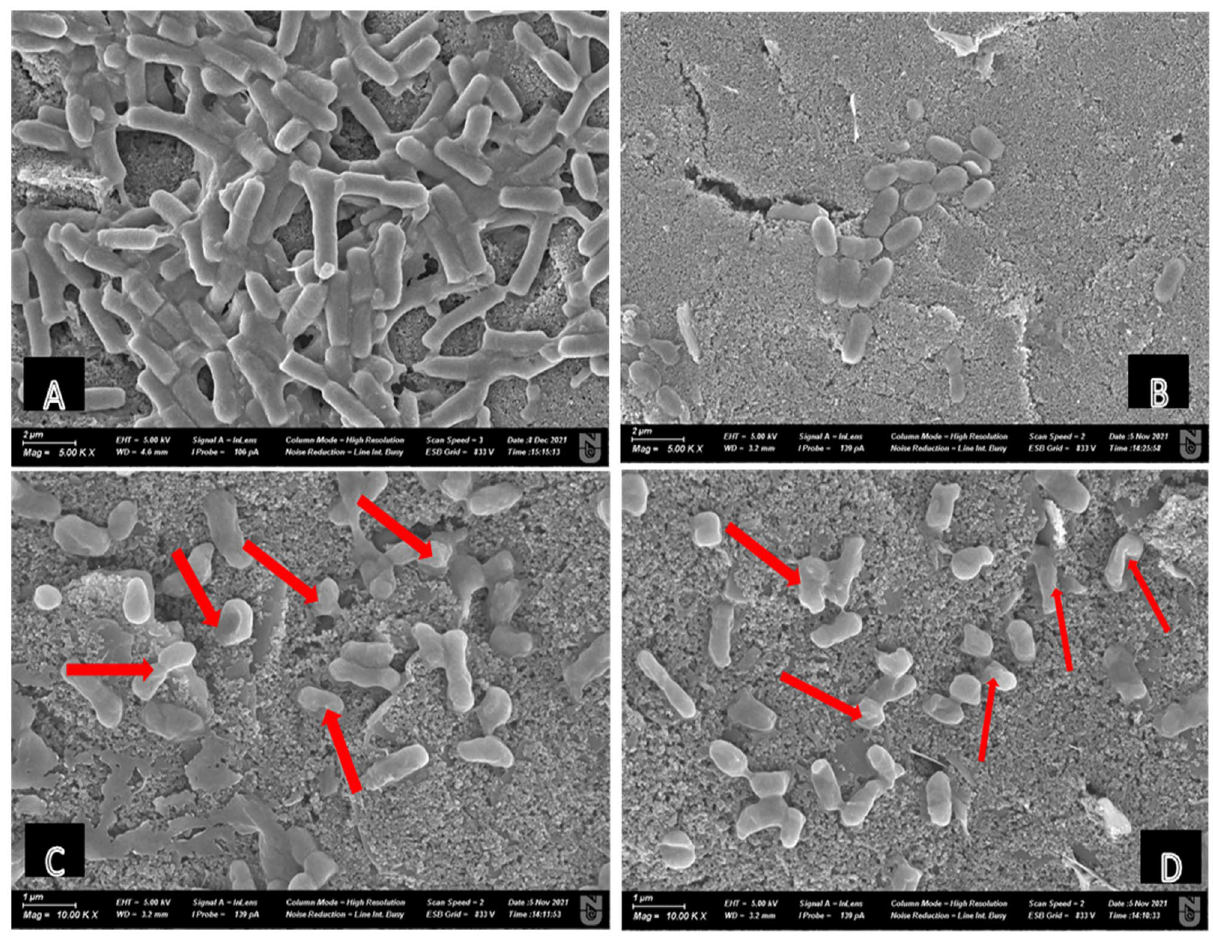
Figure 8. Representative scanning electron micrographs of A. baumannii on the working electrode area only ( A ) cells not treated with any of the tested compounds—Control; ( B ) cells treated with Gen; ( C , D ) cells treated with ZnL1. Red arrows showing point of ell rupture and